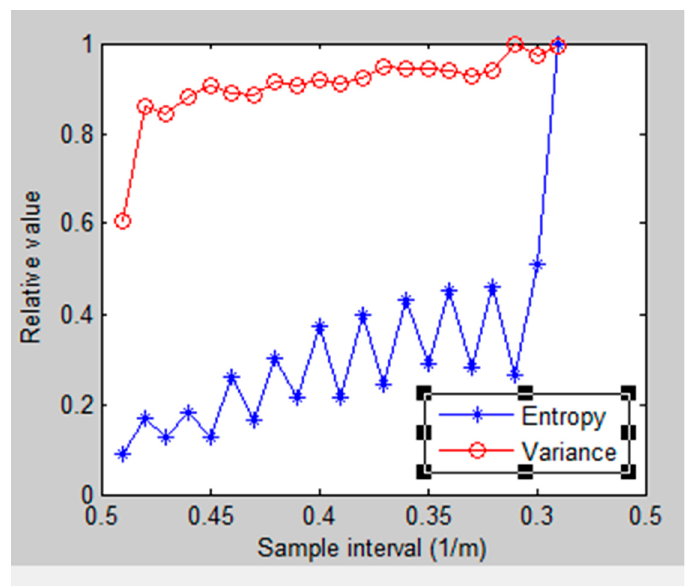
Figure 5. Relationship between the variance and entropy of the imaging result and the sampling interval.